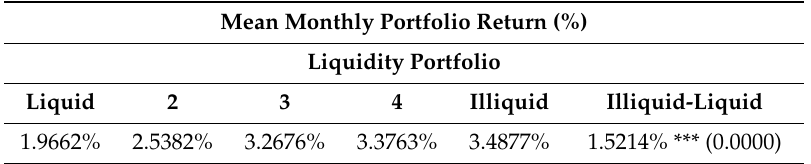
Table 3. Average monthly returns for quintile portfolios (financial crisis).